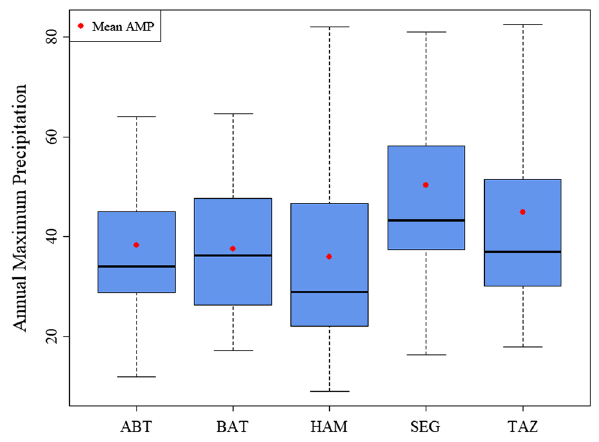
Fig. 2 Boxplot of the annual maximum